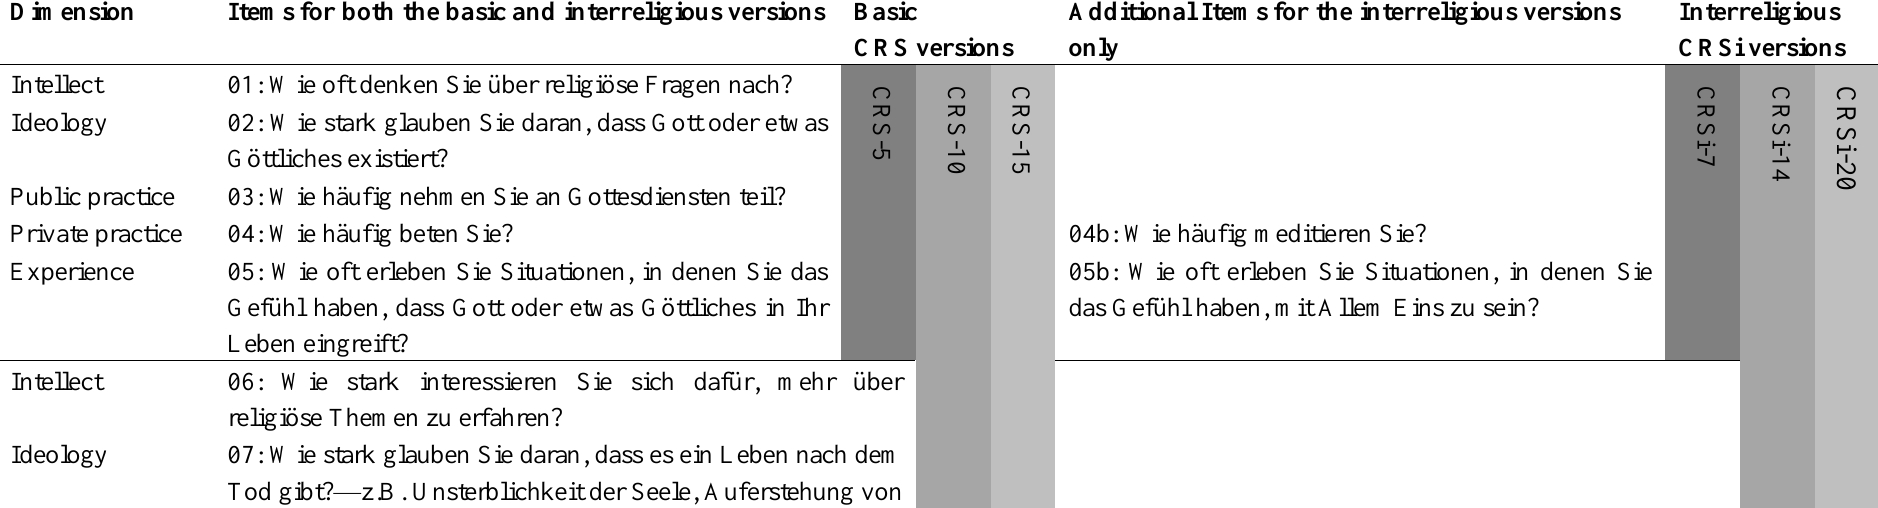
Table 2. Items and versions of the Centrality of Religiosity Scale (CRS)—Original German versions. Dimension Items for both the basic and interreligious